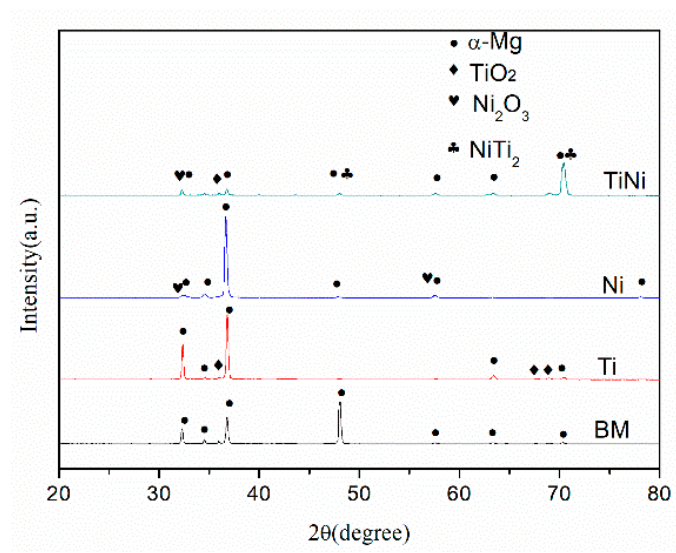
Figure 3. XRD patterns of different samples.